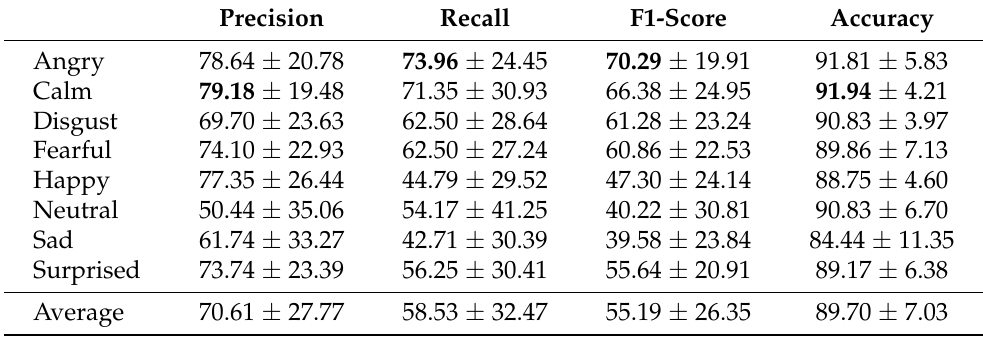
Table 7. Speaker-independent emotion recognition. Average ( ± standard deviation) precision, recall, F1-score, and accuracy across 24 actors of RAVDESS dataset. In each column, the best results are marked in boldface